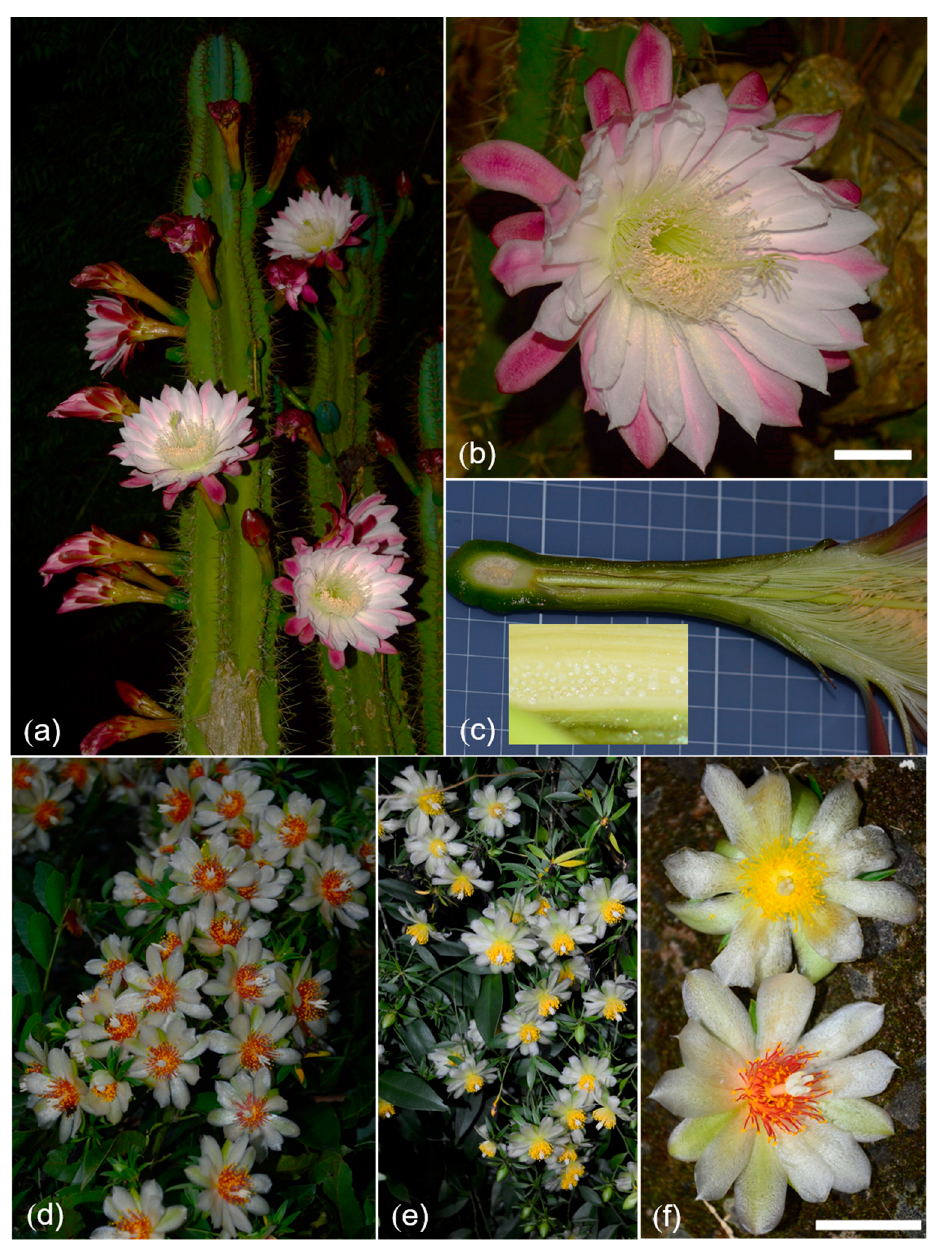
Figure 1. Flower features in the studied species. ( a – c ) Cereus hildmannianus . ( a ) Plant habit. ( b ) Flower in frontal view. ( c ) Flower dissected in longitudinal view. Inset: nectar droplets exuded on the hypanthium. ( d – f ) Pereskia aculeata . ( d – f ) Plant habit. ( f ) Frontal view of flowers with yellow and red stamen filaments. Scale bar in ( b , f ): 2